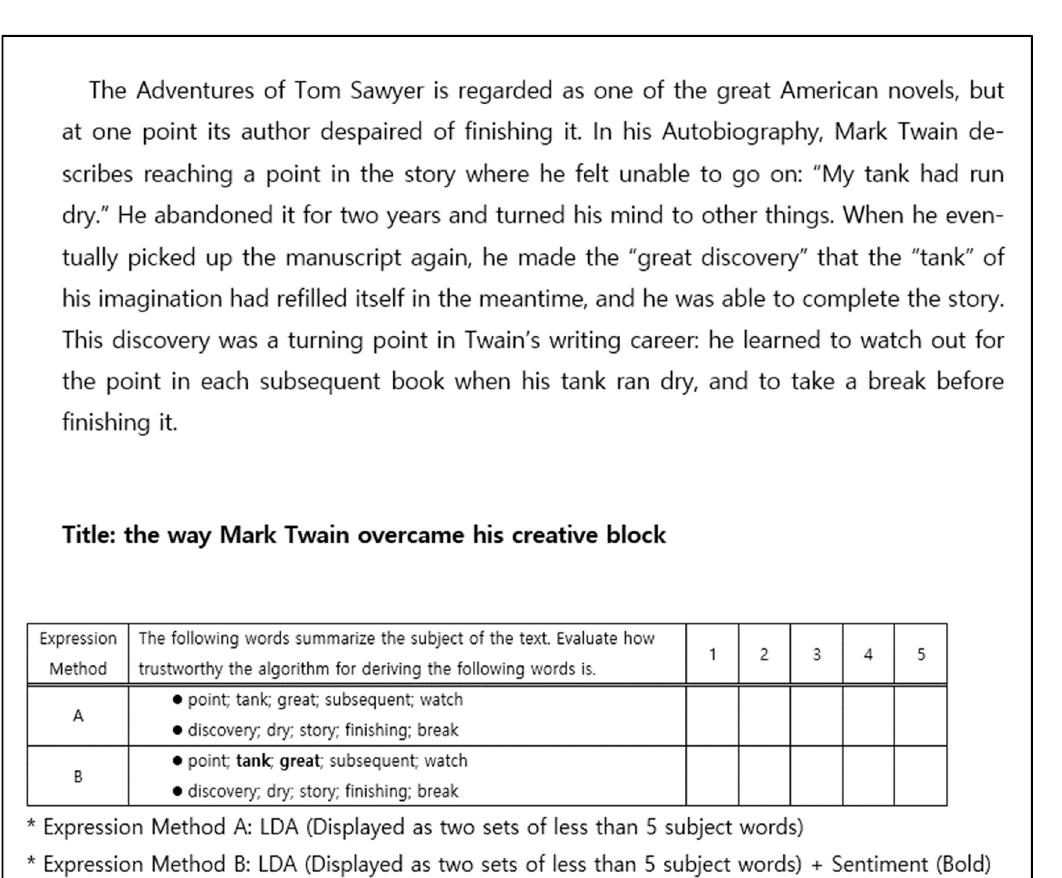
Figure 1. Format of the questionnaire provided to study participants.